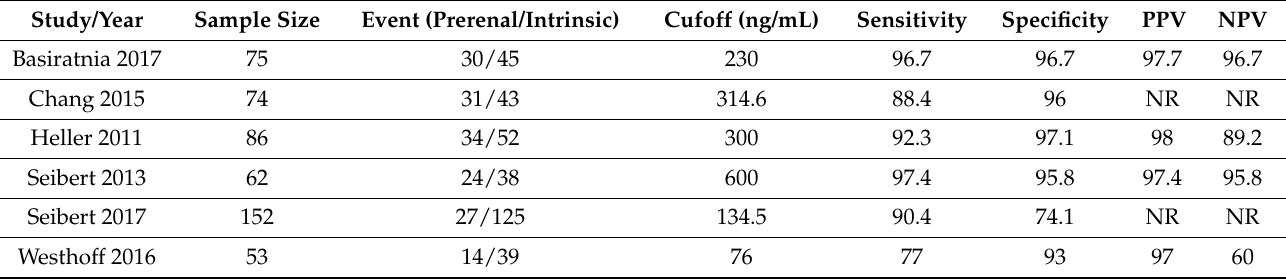
Table 3. Summary of diagnostic performance of the six included